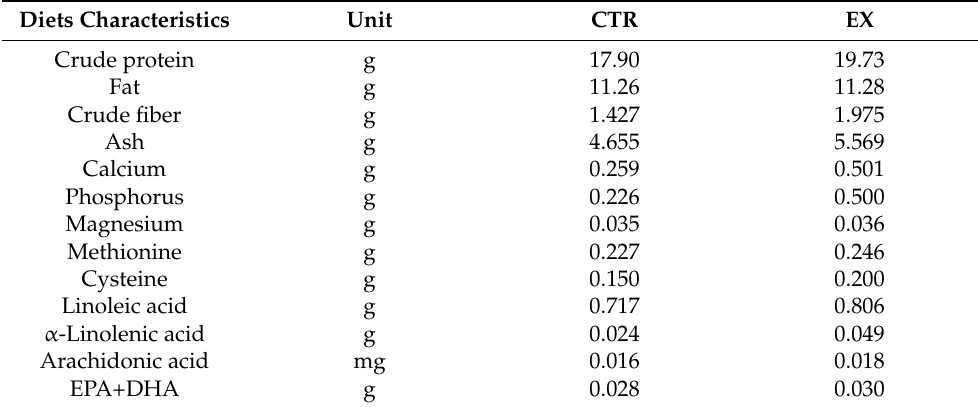
Table 1. Diets characteristics on a metabolizable energy basis (Unit/MJ